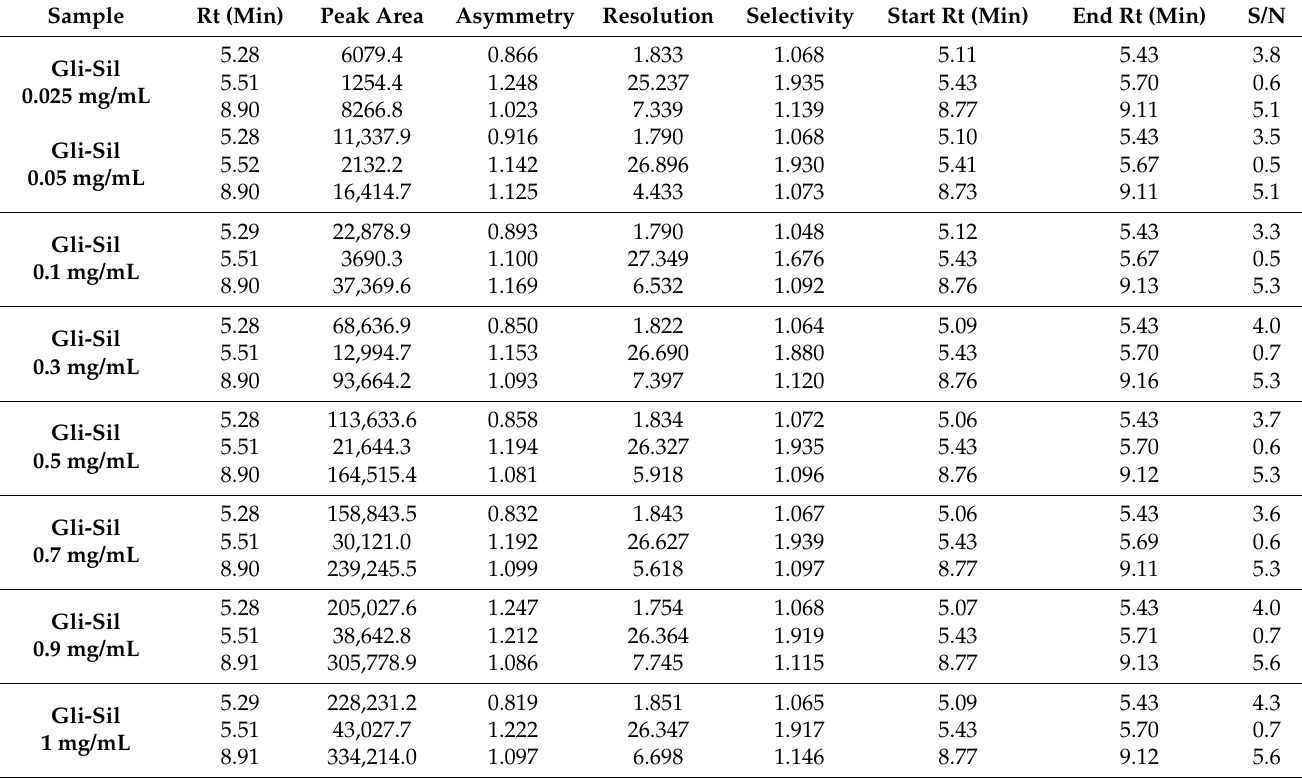
Table 4. The parameters recorded for all studied